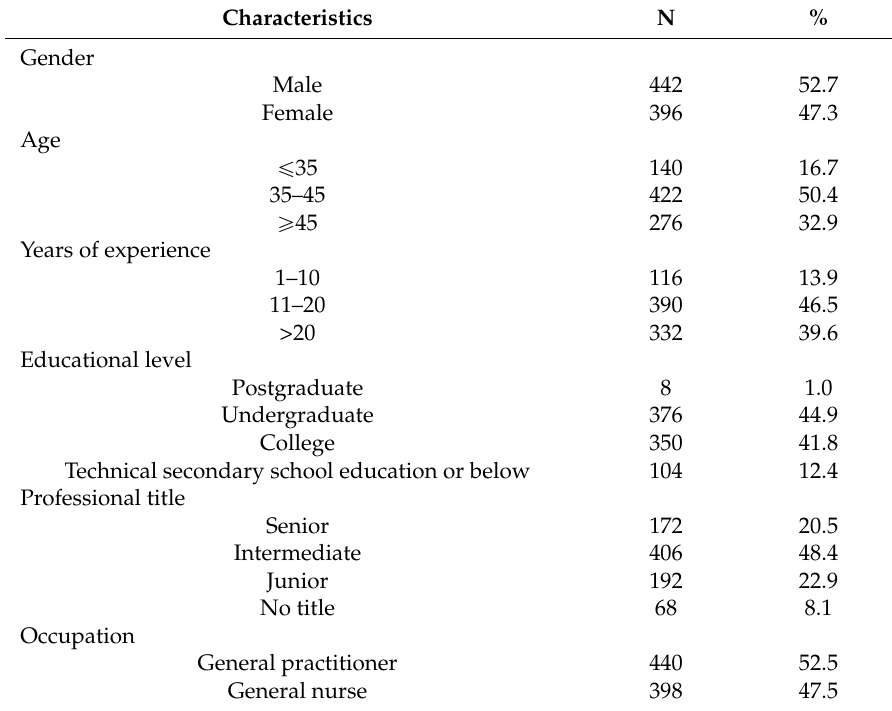
Table 1. Demographic characteristics of the respondents ( N = 838).